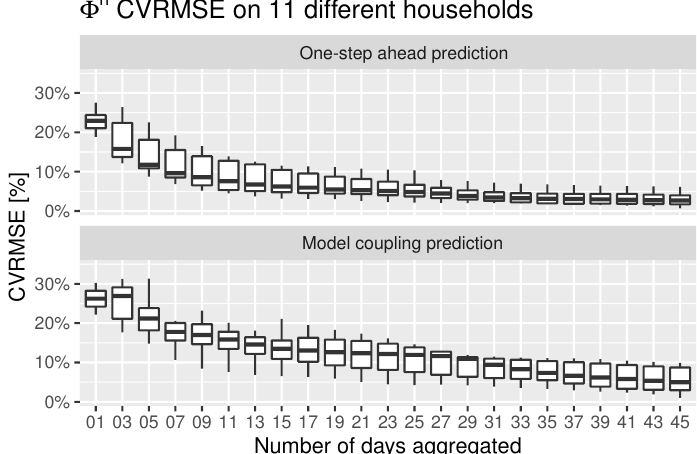
Figure 12. CVRMSE of the space heating consumption of 11 households aggregating data to daily multiples.